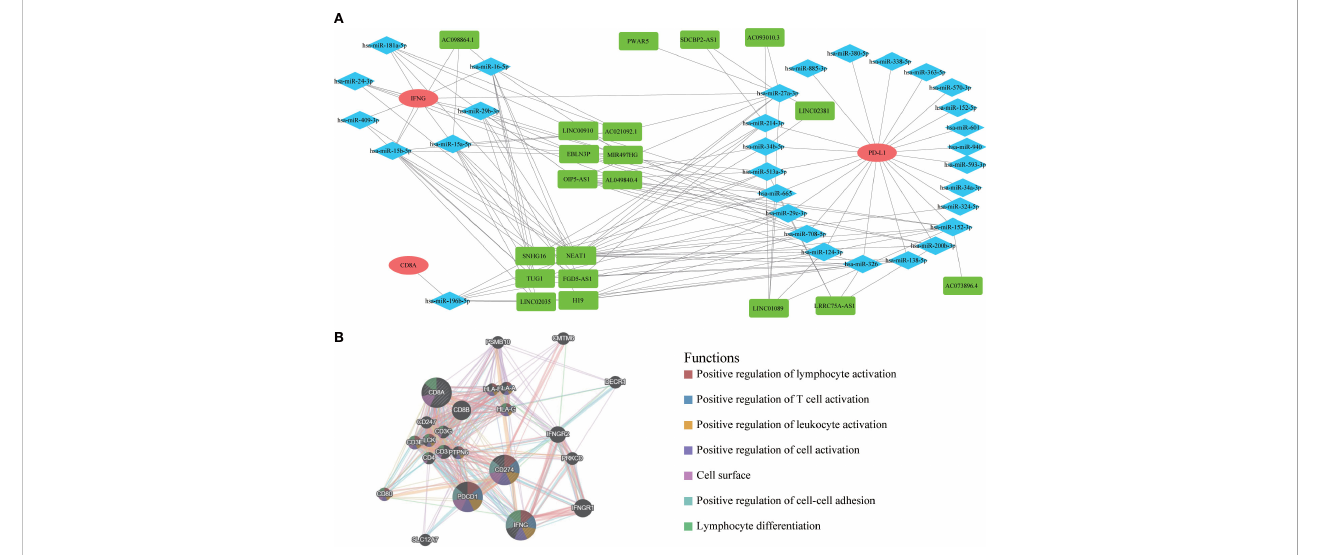
FIGURE 14 The ceRNA network and protein-protein interaction (PPI) network. (A) The ceRNA regulatory network of PD-L1, CD8A and IFNG. Red represented mRNAs; Blue represented miRNAs; Green represented lncRNAs. (B) The PPI network displayed 20 most relevant genes of PD-L1, CD8A, IFNG, and functional enrichment analysis of these 23